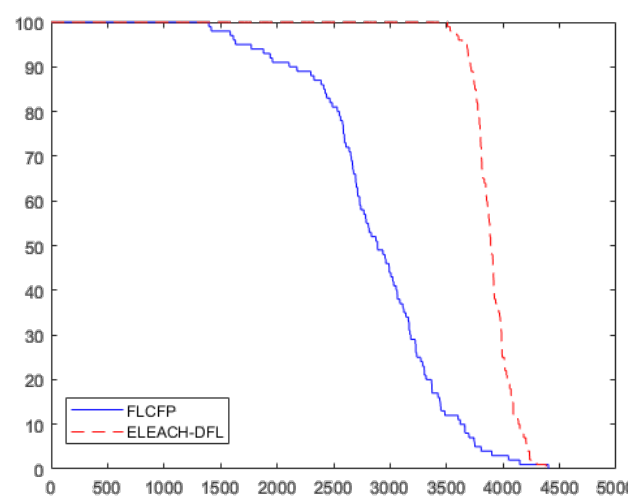
Figure 15. Network lifetime comparison between protocols (BS: outside the sensor field). Table 7. Network lifetime comparisons between protocols.